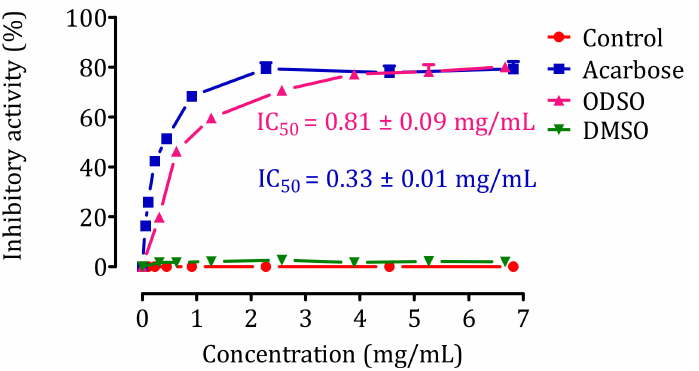
Figure 6. Inhibitory effect of pancreatic α -amylase activity by ODSO and acarbose in vitro. The values are the means ± SEM ( n = 3). ODSO: Opuntia dillenii seed